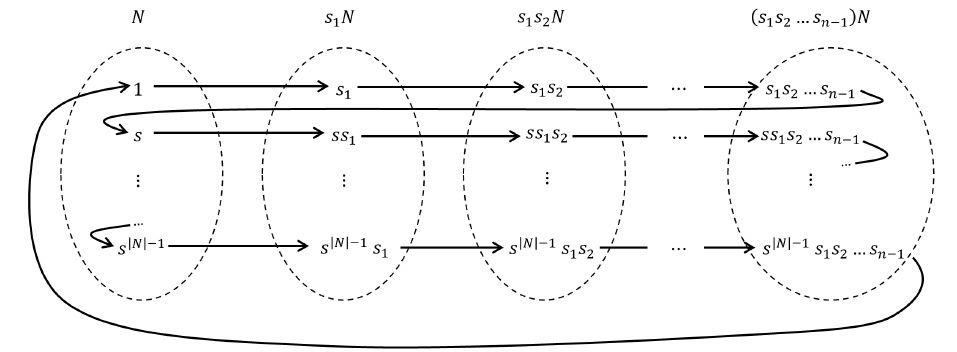
Figure 1. The Hamiltonian cycle explained in the proof of the Factor Group